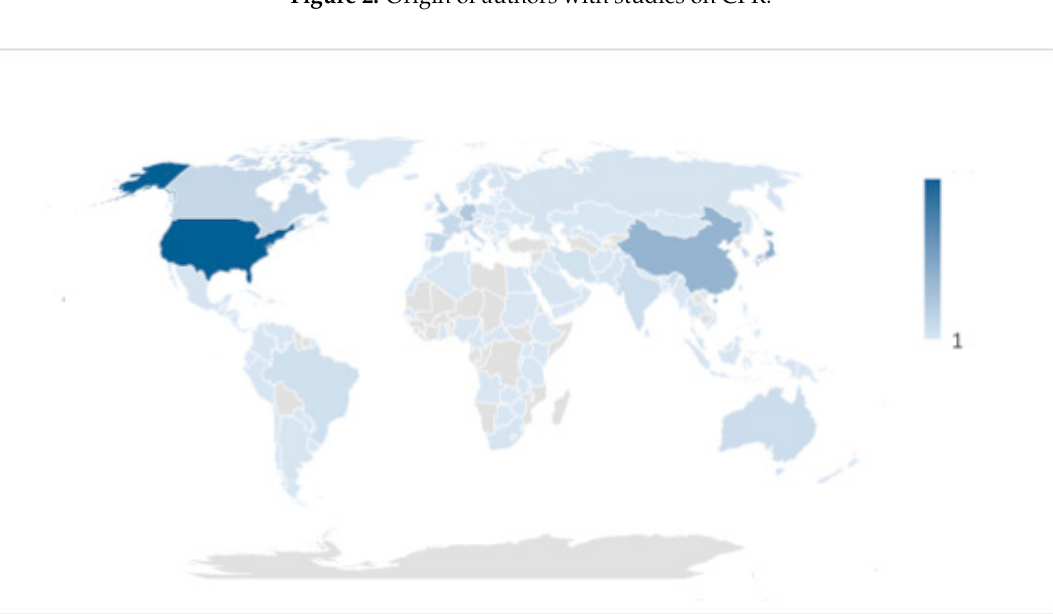
Figure 2. Origin of authors with studies on CPR .